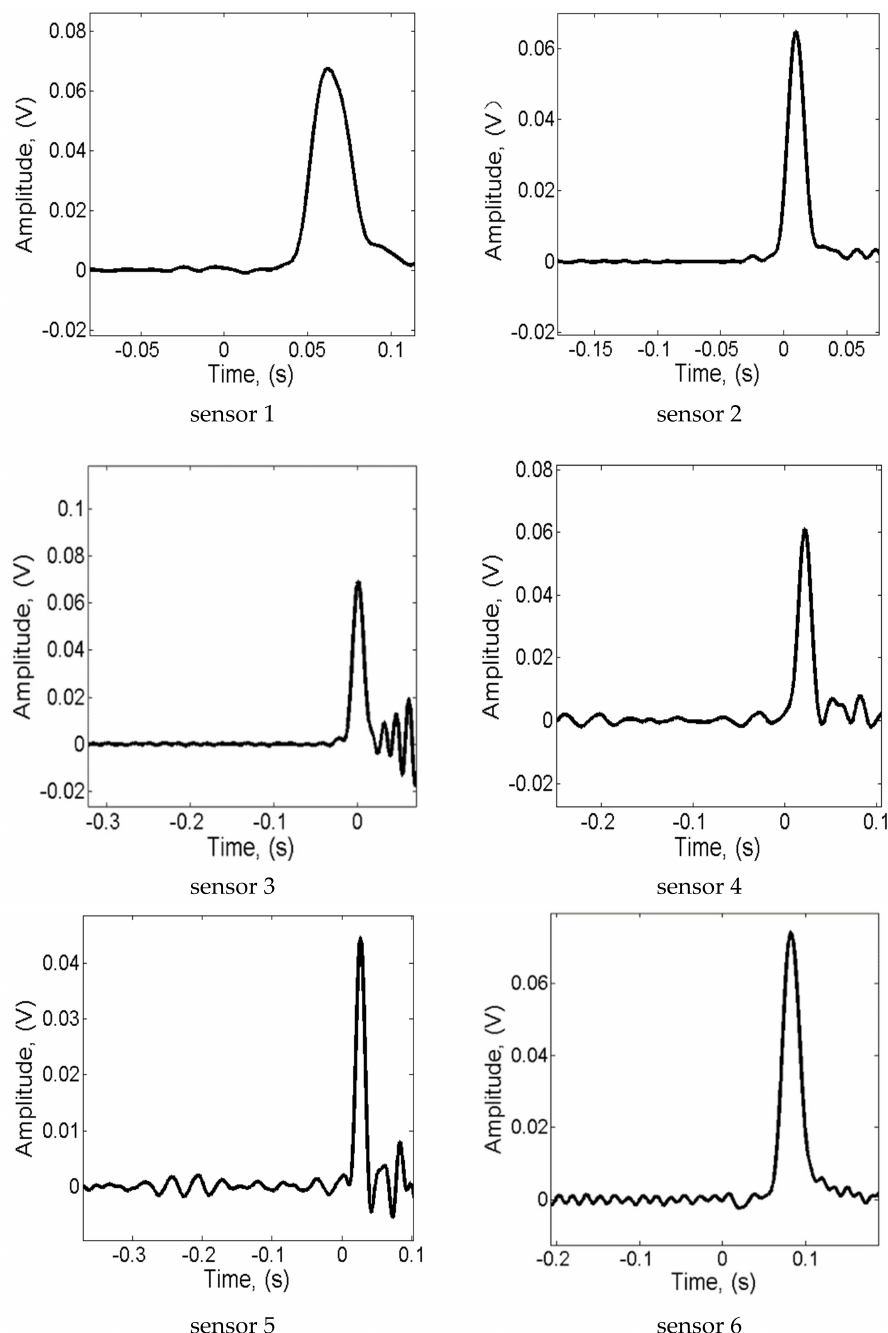
Figure 5. The NPW signals from leakage